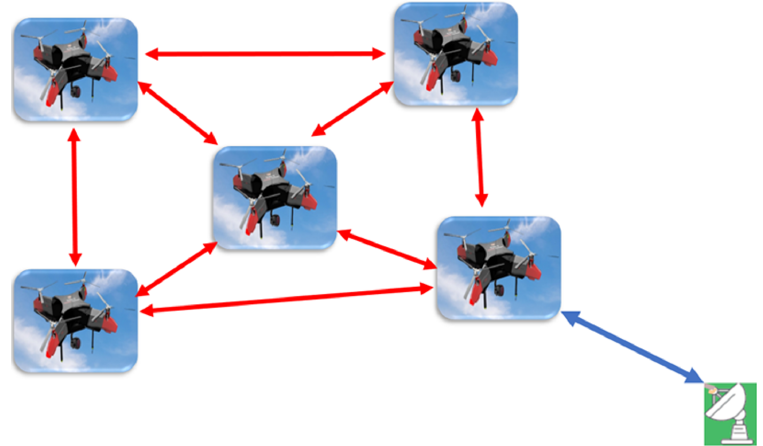
Figure 1. Communication architecture of UAV swarms based on